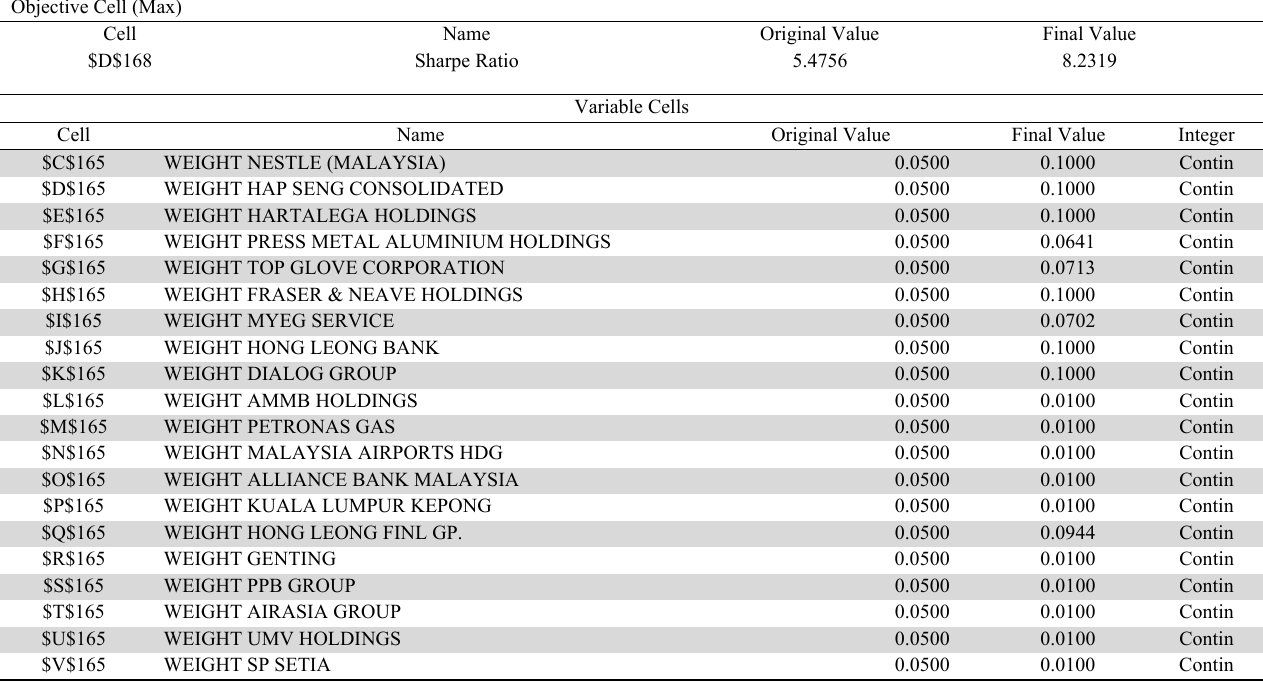
Optimization report (Bottom Rating portfolio